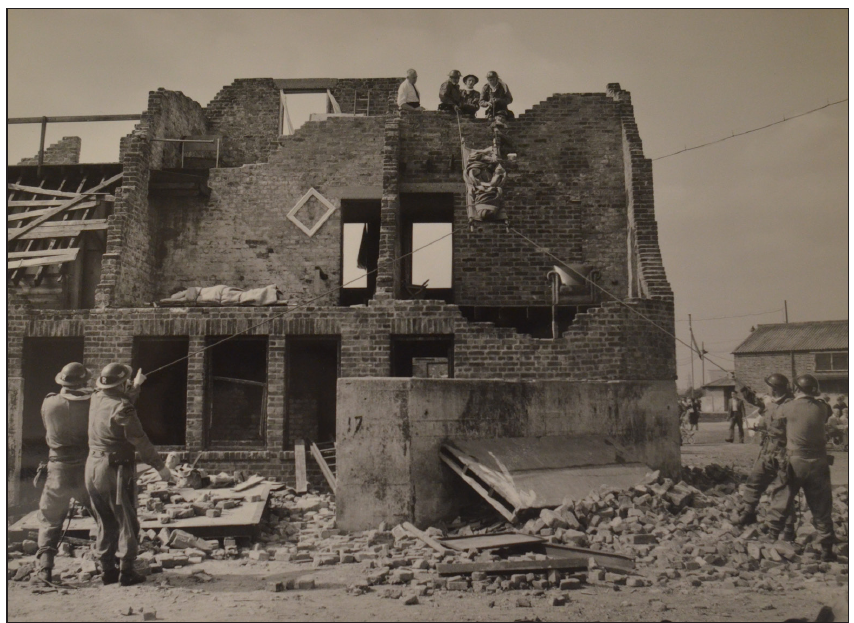
Figure 2: Volunteers practicing rescue from a simulated nuclear attack at Bully Fen Civil Defence Corps Rescue Training Ground in the Civil Defence Competition Finals in 1964. The site today is now close to the former London 2012 Olympic Velodrome. Reproduced with permission © London Metropolitan Archives (City of London): Bully Fen –